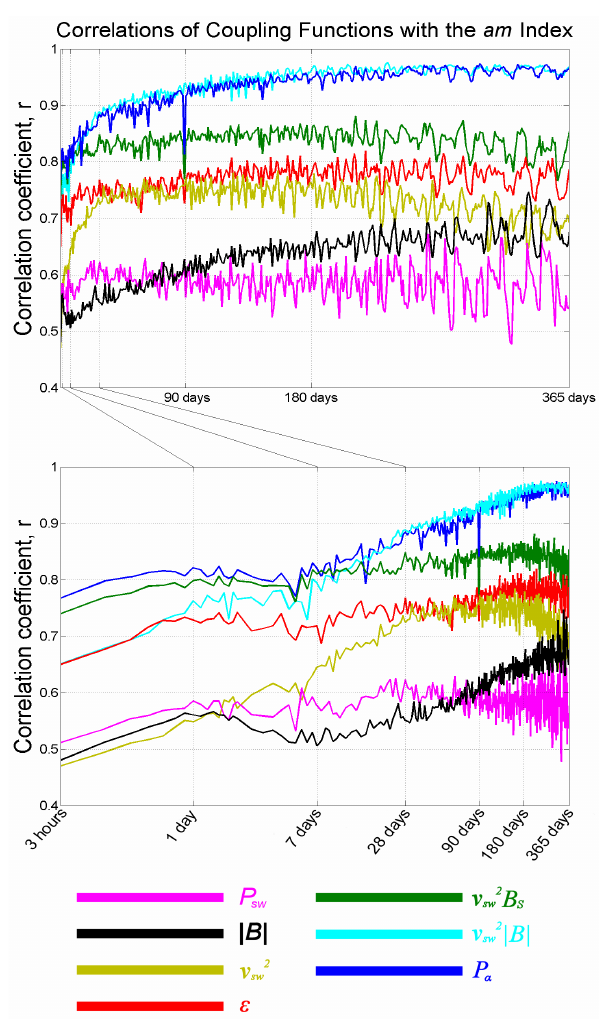
Figure 8: Correlations between the 𝐴𝑚 geomagnetic activity index and a number of solar wind coupling functions, as a function of averaging timescale, T . Upper and lower graphs are identical, other than that the upper graph displays timescale linearly, whereas the lower graph displays it logarithmically. The coloured lines give the results for: 𝑃 𝛼 (dark blue), 𝑉 2 𝐵 (light blue), 𝑉 2 𝐵 𝑆 (green), 𝜖 (red), 𝑉 2 (olive), 𝑃 SW SW SW SW (magenta), and 𝐵 (black). Image reproduced by permission from Finch and Lockwood (2007), copyright by